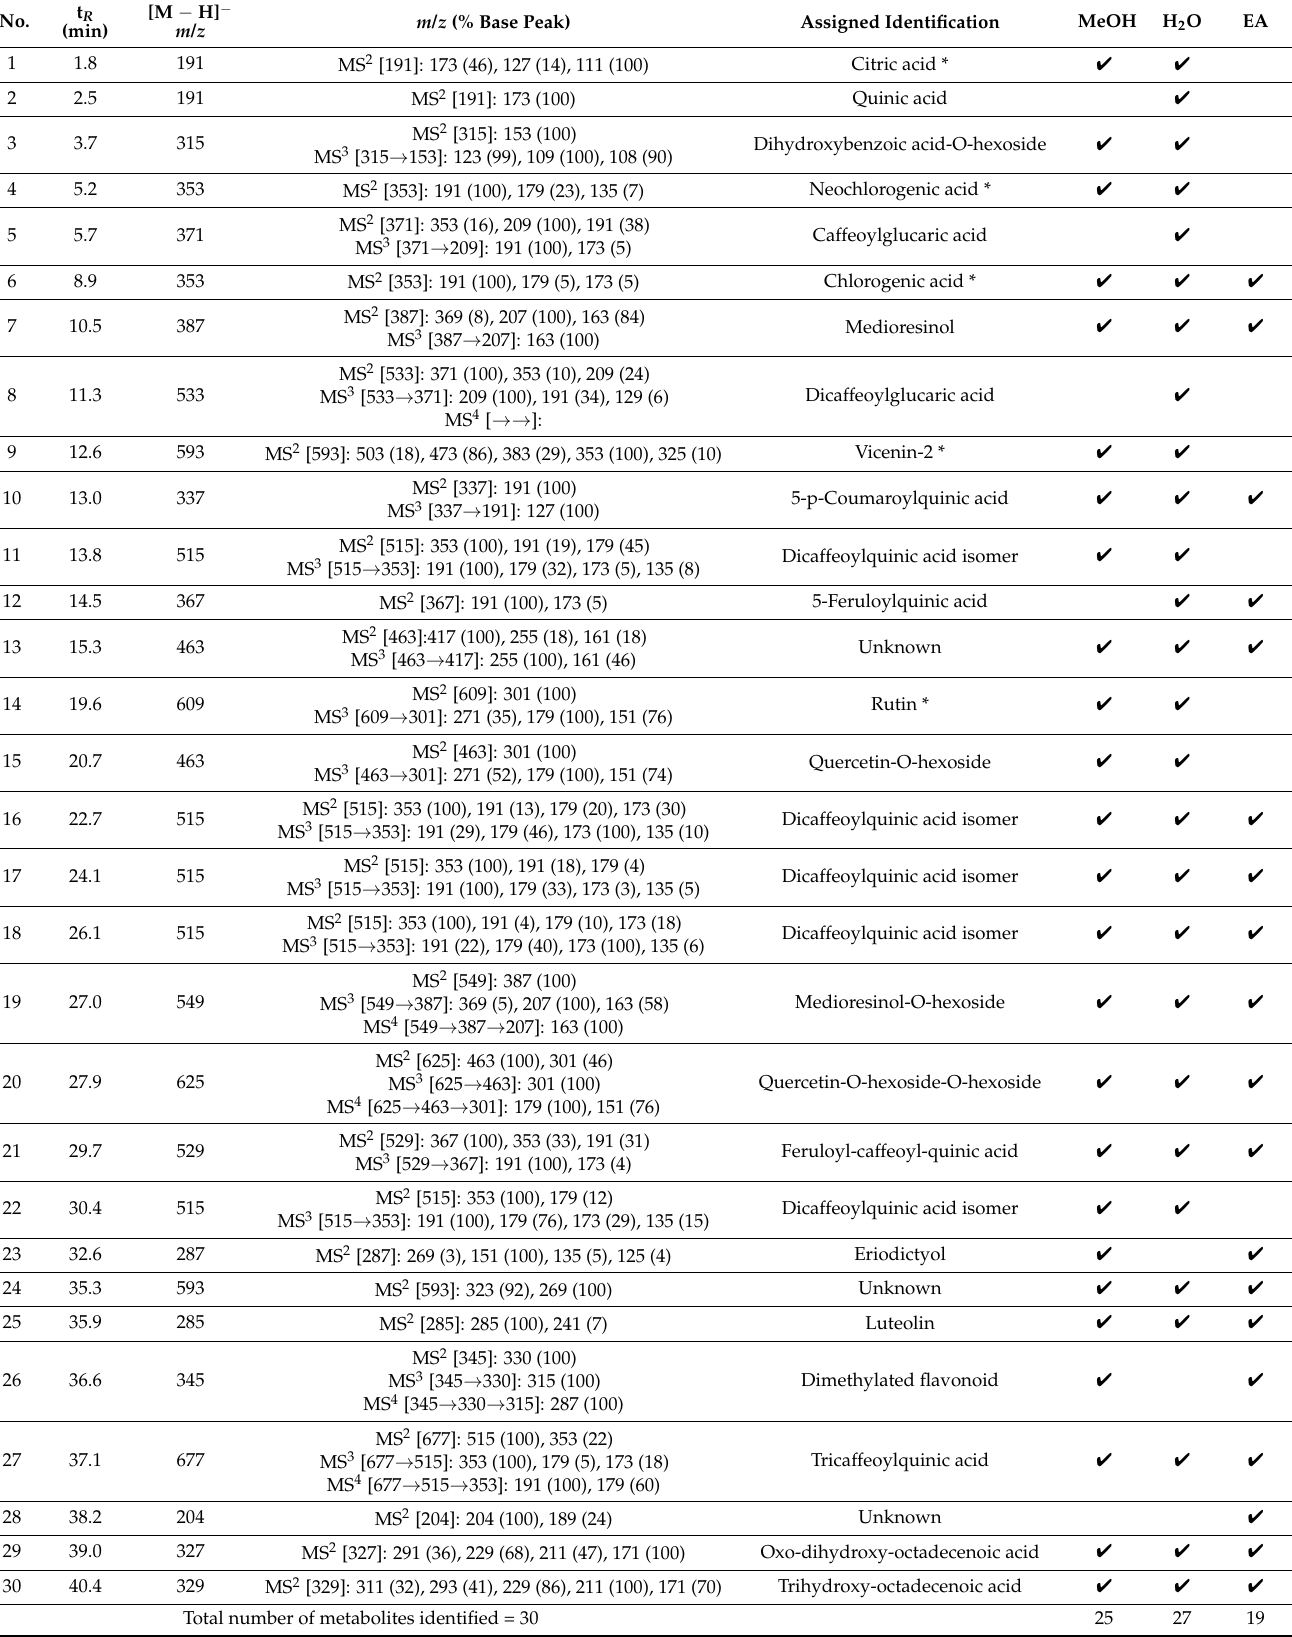
Table 2. Characterization of the compounds found in the analyzed extracts of Artemisia verlotiorum